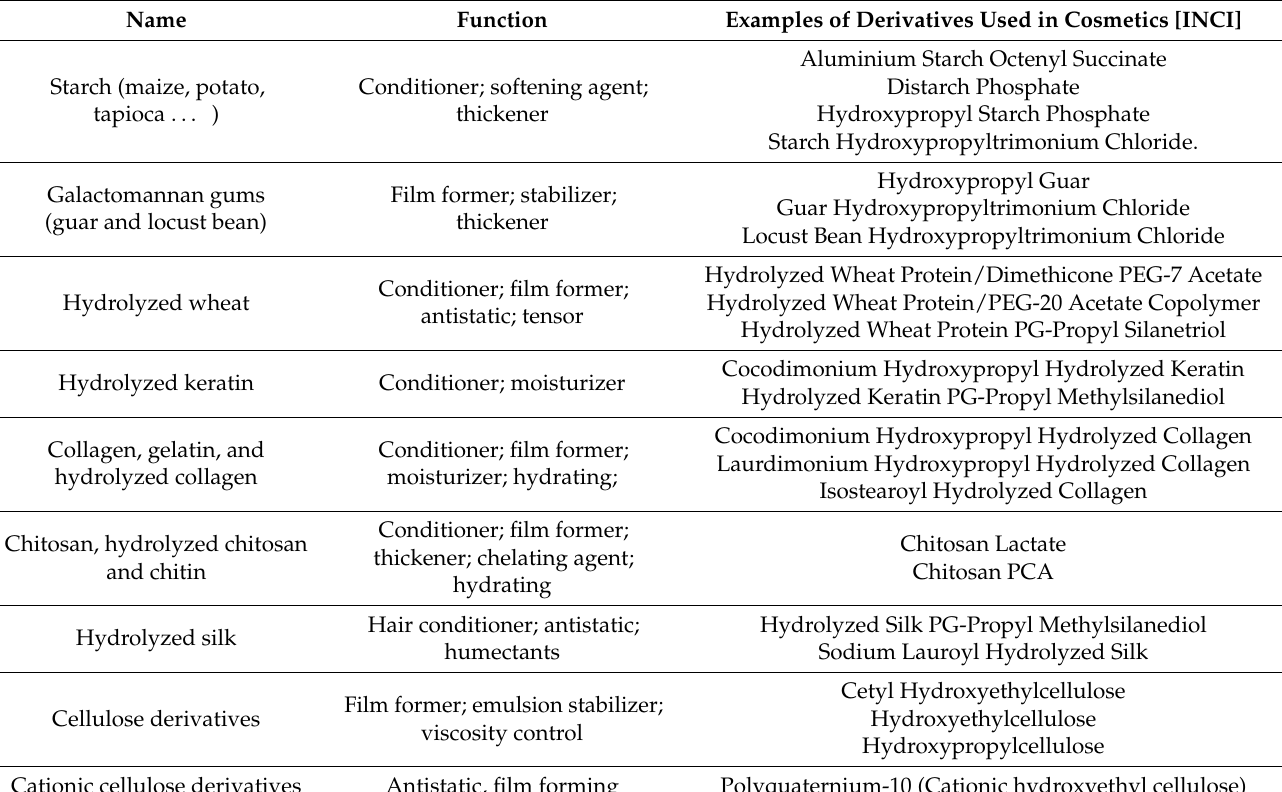
Table 3. Main natural polymers and their derivatives used in hair conditioning products. Data collected from reference